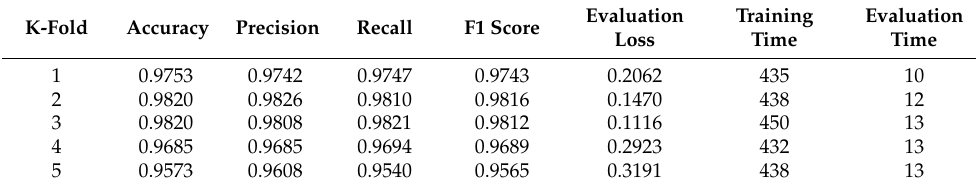
Table 10. BERT—BBC Text dataset.